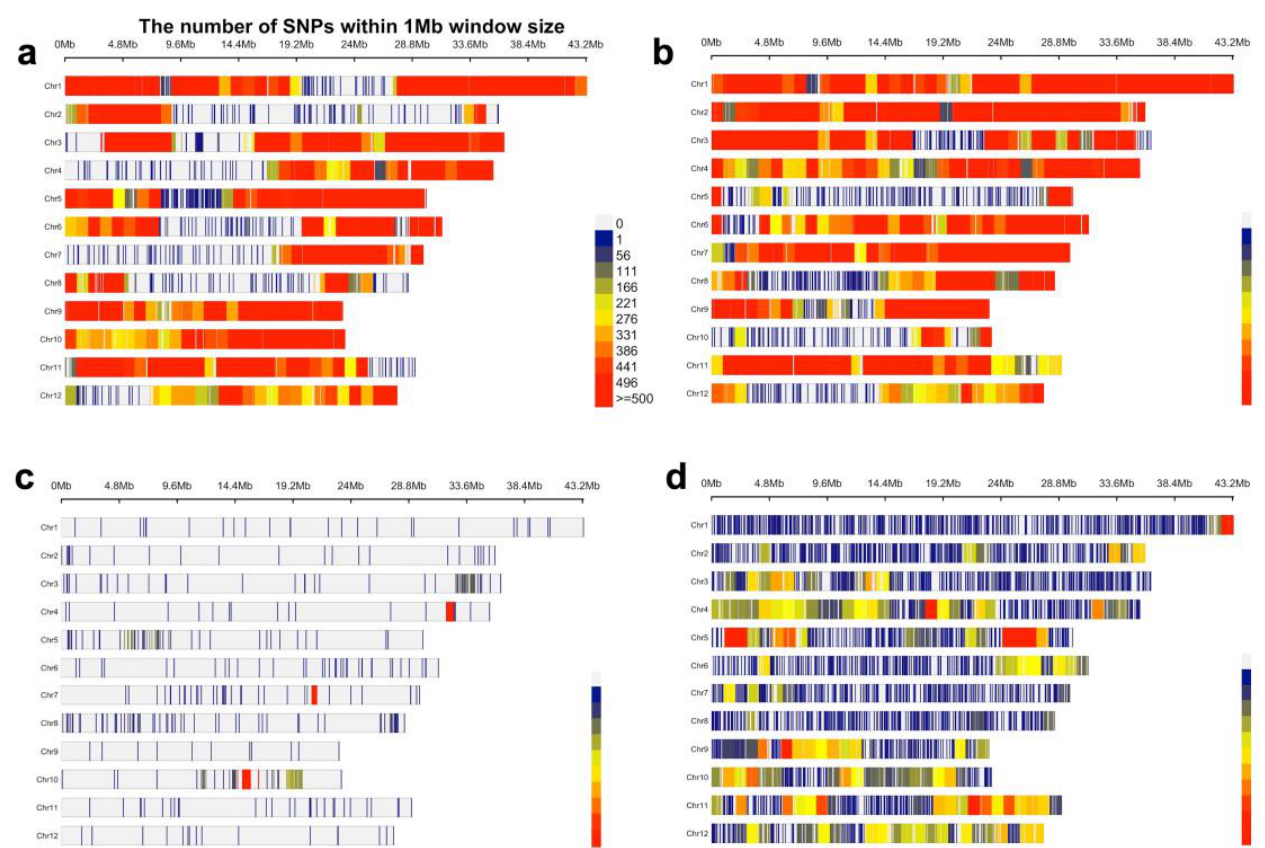
Figure 3. Genetic background analysis of Pup1 introgression lines, MS11-Pup1A ( a ); MS11-Pup1B ( b ); TR22183-Pup1 ( c ); Dasanbyeo-Pup1 ( d ) at BC 2 F 12 using the KNU Axiom Oryza 580 K Genotyp- ing Array containing SNPs polymorphic between RP and DP with reference to IRGSPv1.0.